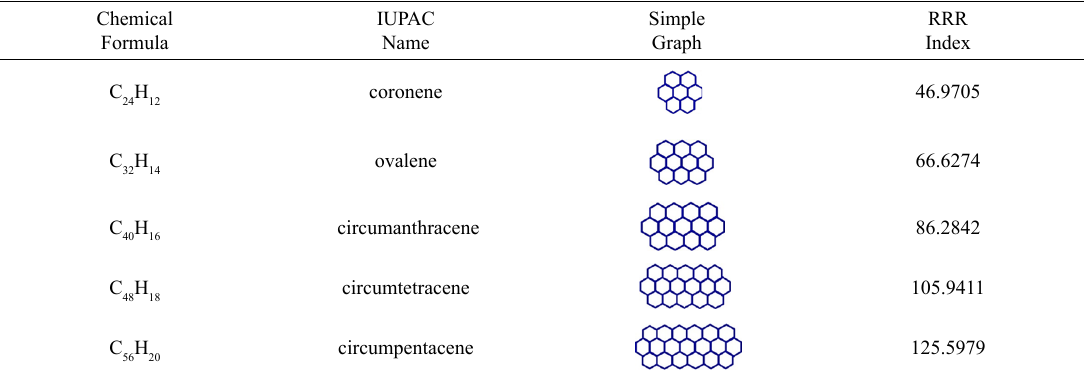
Table 1. RRR index for the first five members of Circumacenes family.